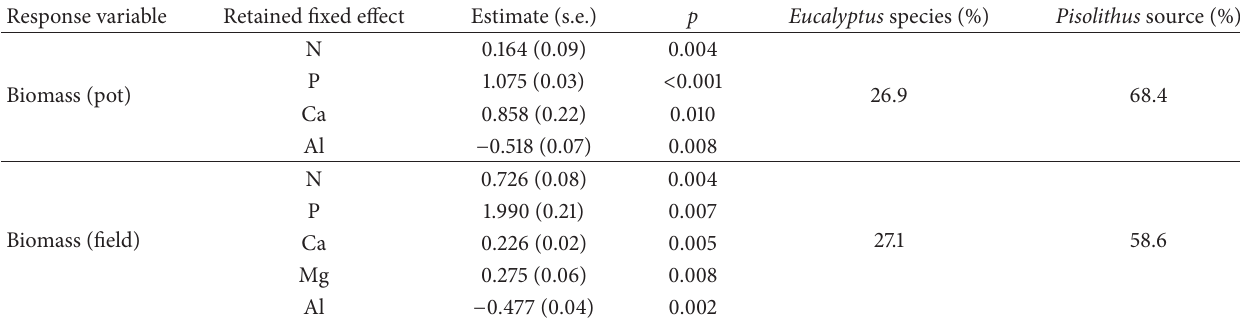
Table 2: Residual maximum likelihood (REML) results of the influence of Eucalyptus species and Pisolithus isolate source as explanatory factors on plant biomass and mineral nutrition in pot and field trials. The significant fixed effects (nutrients), their standardized estimates with standard error (s.e.), p values, and the amount of variation explained by plant and mycorrhizal parameters are presented. Response